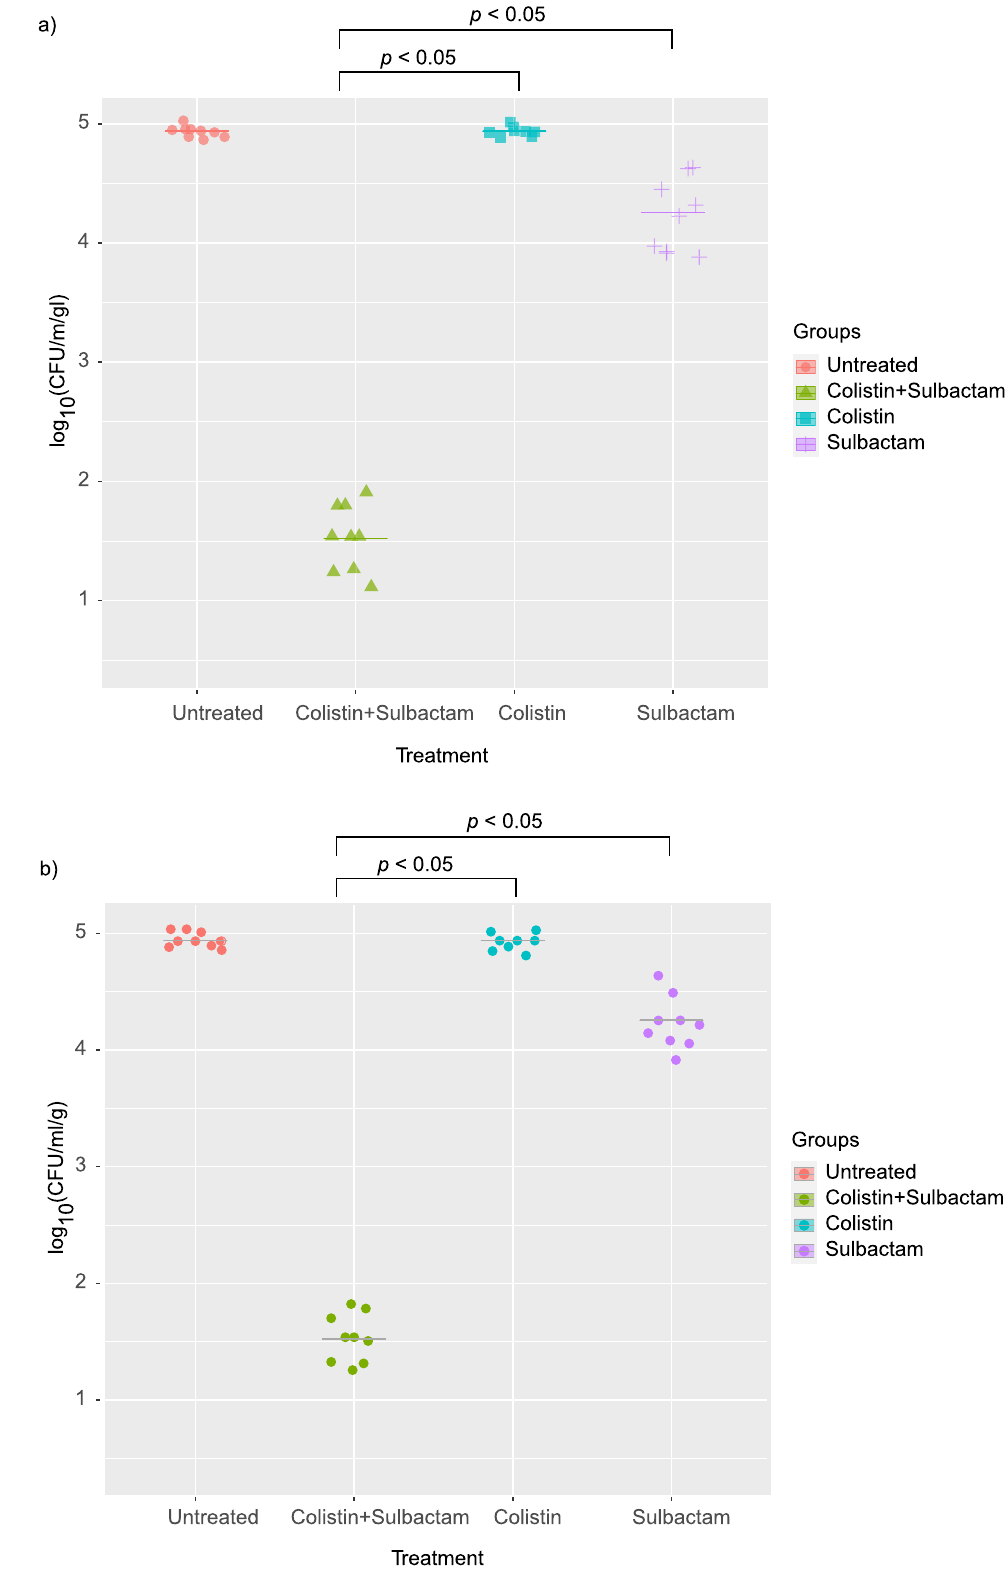
Figure 4. Colistin and sulbactam combination therapy is efficacious in mouse thigh models of infection. ( a ) Single-dose treatment at 1 h post infection of either colistin (20 mg kg −1 , i.p. n = 10), sulbactam (120 mg kg −1 , p.o. n = 10), untreated (n = 10), or the combination (n = 10) in a neutropenic mouse thigh infection model using representative colistin-resistant A. baumannii isolates ( a ) 1251 and ( b ) 1374. Colony-forming units (CFU) within thigh tissue were enumerated at 8 h post infection and compared to the untreated group. Horizontal lines represent geometric mean of the bacterial load for each treatment group. P values were determined using a two-sided, Mann–Whitney